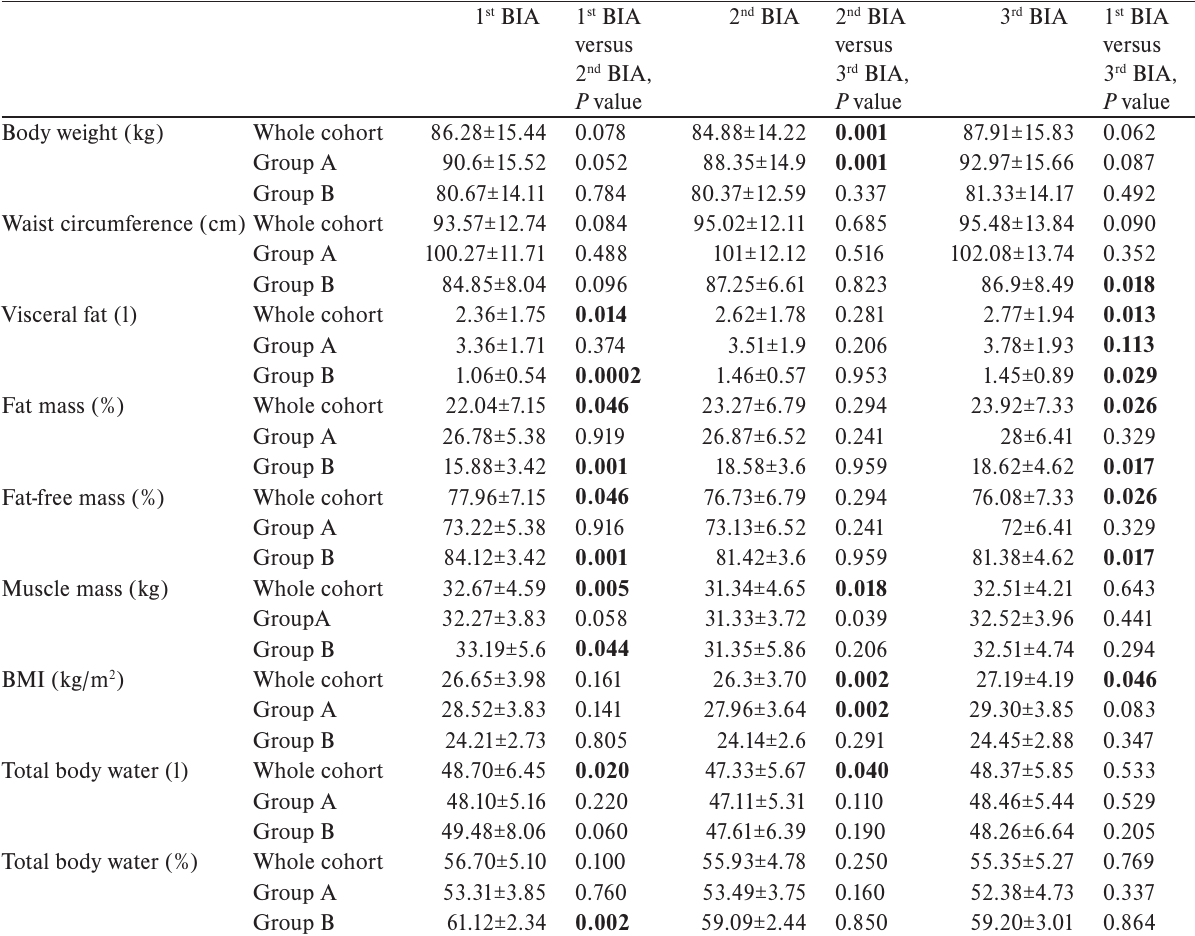
Table 2. Changes in body composition in patients with testicular tumours undergoing chemotherapy. All measured values are